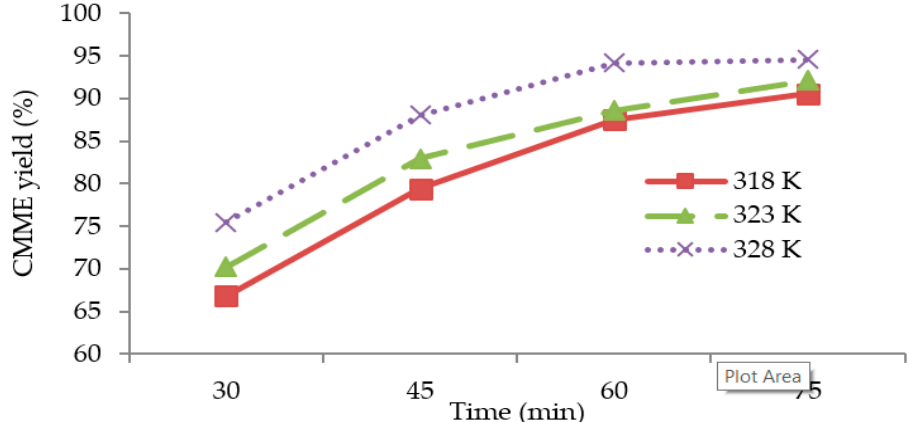
Figure 4. CMME yield as a function of time for three different reaction temperatures. Note that these plots are plotted based on the optimum process parameters (methanol to oil molar ratio: 11:1, catalyst concentration (KOH): 1.2 wt. %, stirring speed: 1000 rpm).